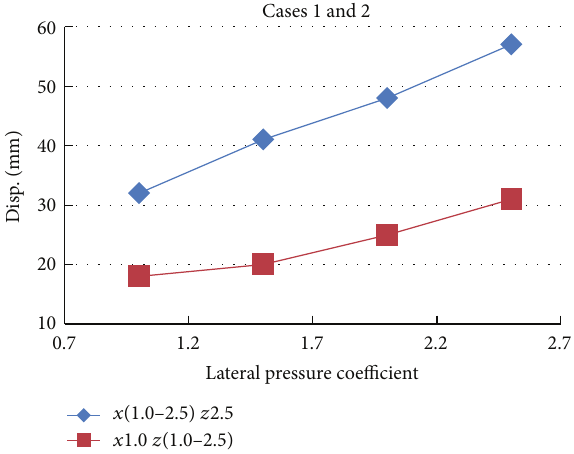
Figure 13: Key point displacement in side wall versus lateral pressure coefficient in cases 1 and